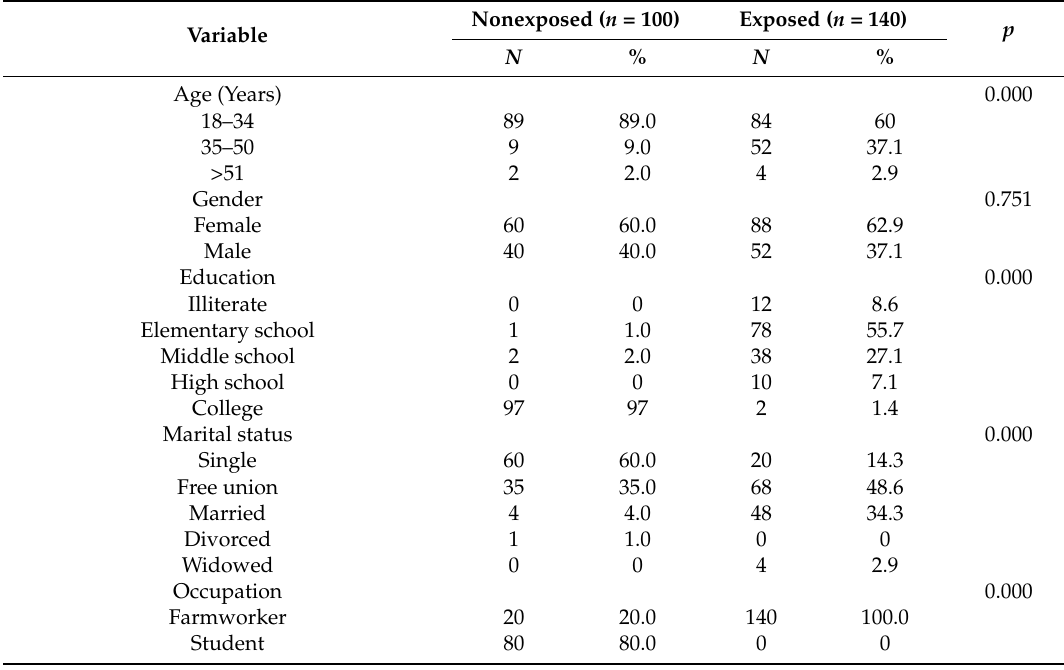
Table 1. Sociodemographic characteristics of the general study population. p -values were obtained with the Chi-Square test. p < 0.05 was considered statistically